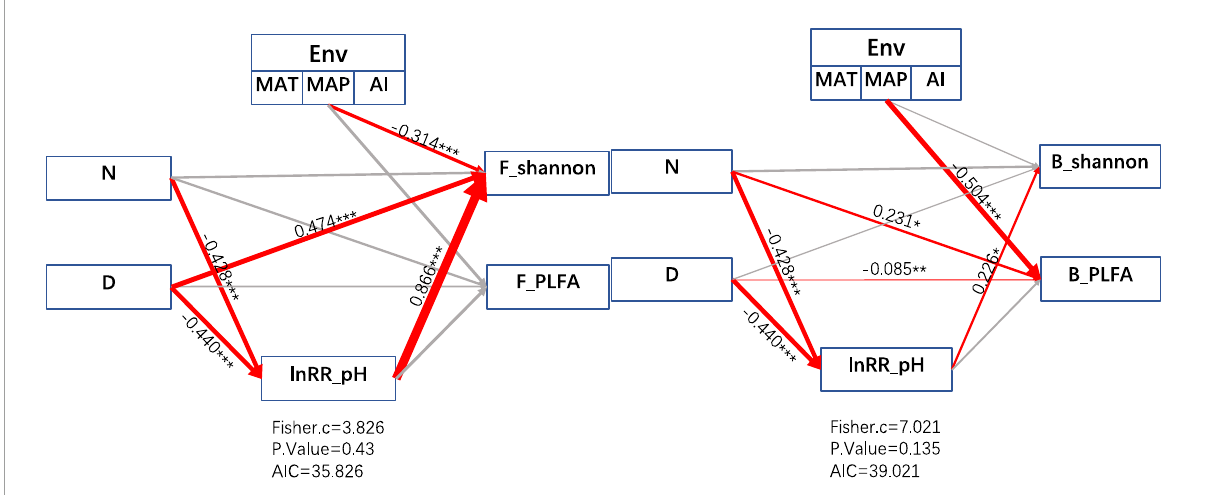
FIGURE6 Structural equation modeling (SEM) depicting the effects of multiple drivers on bacterial (B) and fungal (F) Shannon index response ratios and PLFA. D: duration of N fertilizer addition experimental time (years); N: fertilizer addition amount (kg ha − 1 yr − 1 ); ln RR _pH is the response ratio of soil pH to microbial PLFA and Shannon diversity under N addition. Environmental factors (ENV) include annual mean temperature (MAT), annual rainfall (MAP), and aridity index (AI). Red arrows and gray arrows indicate significant or insignificant correlations, respectively. The numbers adjacent to the arrows are the normalized path coefficients, which are like relative regression weights and represent the magnitude of the effect of the relationship. The thickness of the arrows is proportional to the magnitude of the normalized path coefficients or covariance coefficients. Fisher.C: Fisher’s C statistic; P Value: probability level; AIC: Akaike’s information